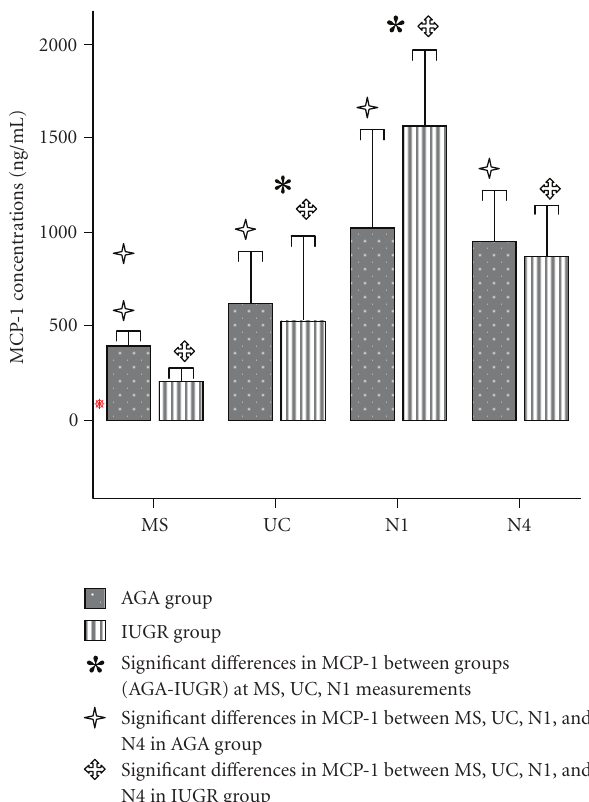
Figure 1: MCP-1 concentrations in the plasma of mothers (MS), fetuses (UC), and neonates on day 1 (N1) and 4 (N4) postpartum in appropriate for gestational age (AGA) and intrauterine growth restricted (IUGR) groups. Bars represent the mean values and error bars one SD of the